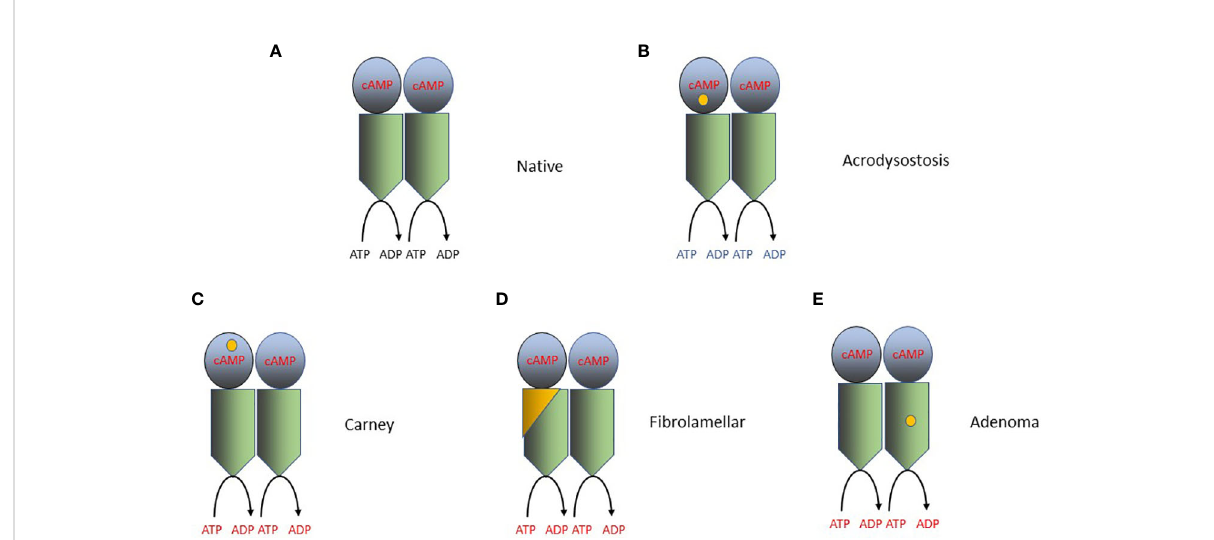
FIGURE 2 Mutations that activate PKA in cancer and other disorders. PKA catalyzes the phosphorylation of serine and/or threonine amino acids located at speci fi c sites in its protein substrates. ATP is the phosphodonor and therefore the reaction converts ATP to ADP. The PKA holoenzyme is a tetramer of 2 catalytic subunits (C-subunits, C a or C b ; blue in the fi gure), and 2 regulatory subunits (R-subunits, RI a , RI b RII a or RII b ; green in the fi gure). The RI a subunit is encoded by PRKARA1A and the C a or C b subunits are encoded by PRKACA and PRKACB , respectively. Each R subunit forms a homodimer through the interaction of helices at its amino terminus and also interacts with at least one C subunit. cAMP binds to a speci fi c domain located within each R subunit and produces a conformational change in the PKA holoenzyme, increasing its catalytic (protein kinase) activity. The location of the speci fi c driver mutations in PKA implicated in oncogenesis are shown in each panel by a yellow dot. (A) The native (wild-type) PKA holoenzyme. (B) Mutations producing acrodysostosis. These mutations are localized to the second cAMP-binding domain of RI a , where they perturb the switch between the active (cAMP-bound) and inactive conformations of PKA. The mutations produce cAMP-resistant PKA holoenzymes and thereby reduce PKA activity. (C) Mutations producing Carney Complex. Mutations in one of several amino acids in RI a reduce the stability of RI a or its interaction with C a / b and therefore increase PKA action. (D) Mutations in fi brolamellar hepatocellular carcinoma. The DNAJB1-PRKACA fusion (yellow and green) is capable of binding to RI a and RII a subunits, creating in each case a functional holoenzyme. DNAJB1-PRKACA holoenzymes are more abundant in cells, producing increased PKA enzymatic activity. (E) Mutations in adrenal adenomas. Mutations in the C a subunit, such as L205R, alters the ability of the C a subunits to be regulated by the R subunits, leading to constitutive, cAMP-independent signaling. The L205R and W196R mutations also appear to exclude the mutant holoenzymes from their AKAP anchors, allowing them to diffuse indiscriminately throughout the cell, producing phosphorylation of non-physiologic PKA